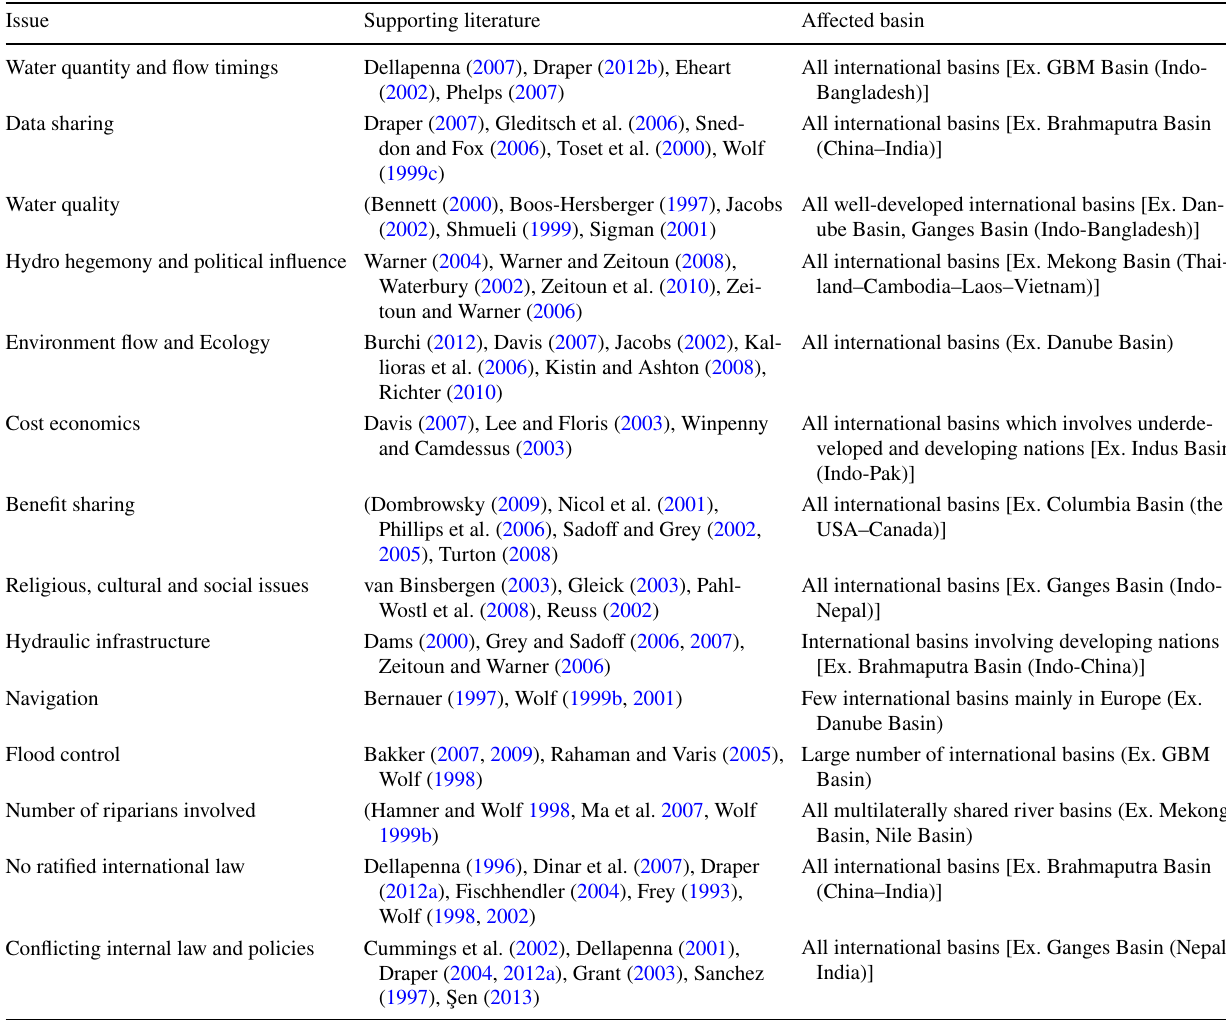
Table 1 Issues affecting international basins supported by the literature